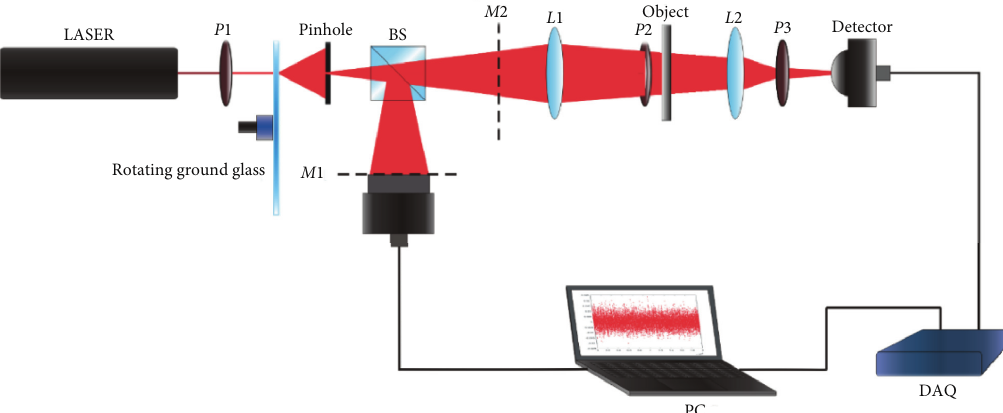
Figure 4: Schematic diagram of the experimental setup.